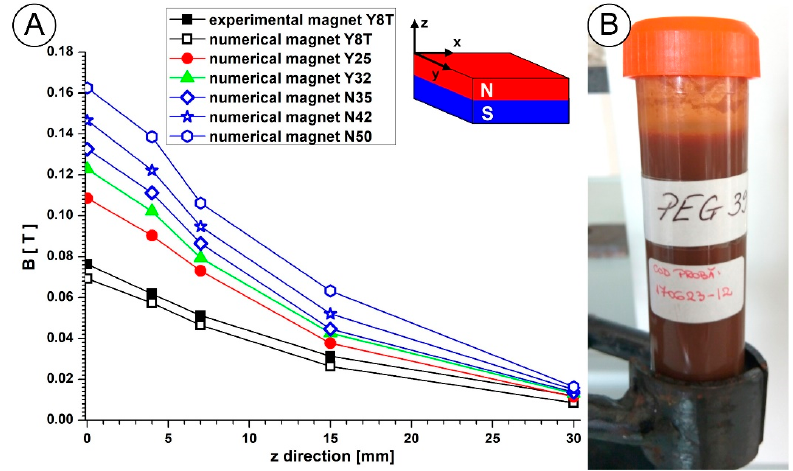
Figure 16. ( A ) Magnetic field induction function of the distance to the permanent magnet surface along the z axis for different types of magnets: the N35...52 Neodymium type magnet and the Y8T...Y32 ferrite type magnet. ( B ) Suspensions of the magnetic carrier containing PEG-coated nanoparticles.